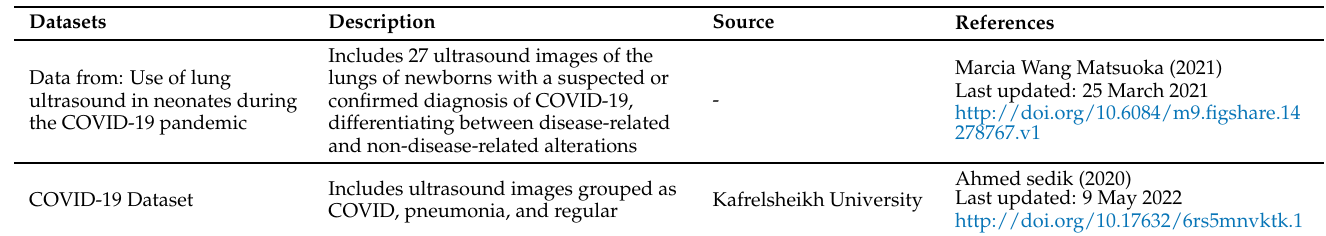
Table 3. COVID-19 Ultrasound Image